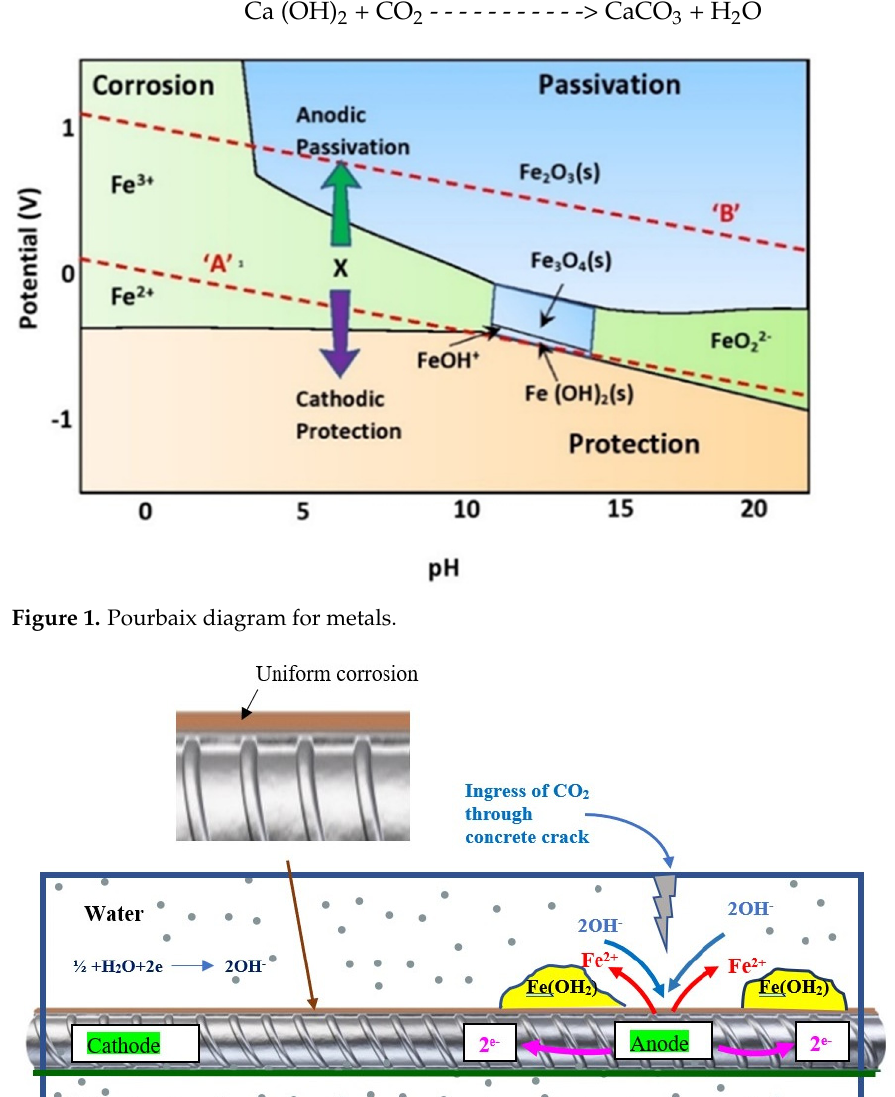
Figure 1. Pourbaix diagram for metals.